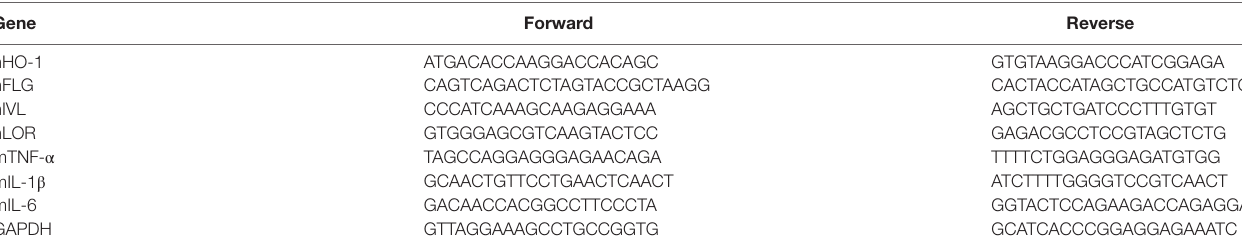
TABLE 3 | Primers utilized for real-time